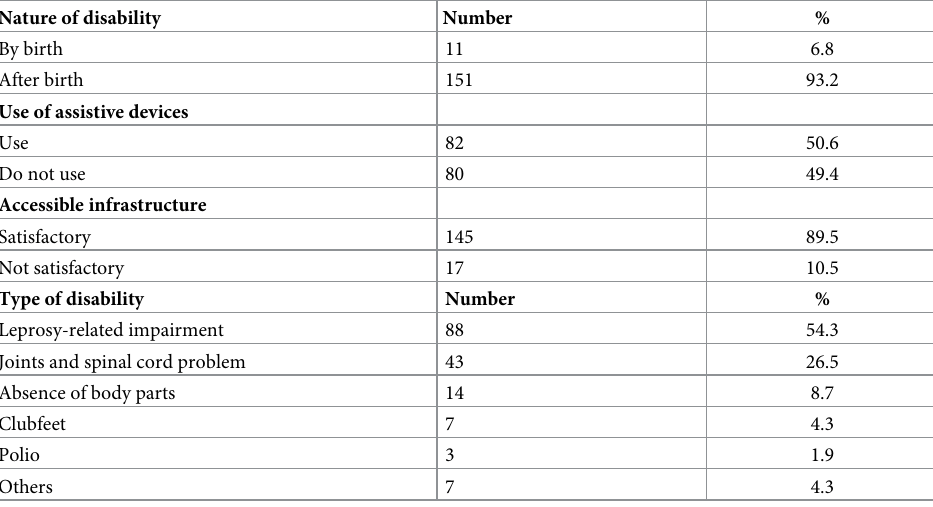
Table 2. Distribution of participants by their nature of disability and types of disability.